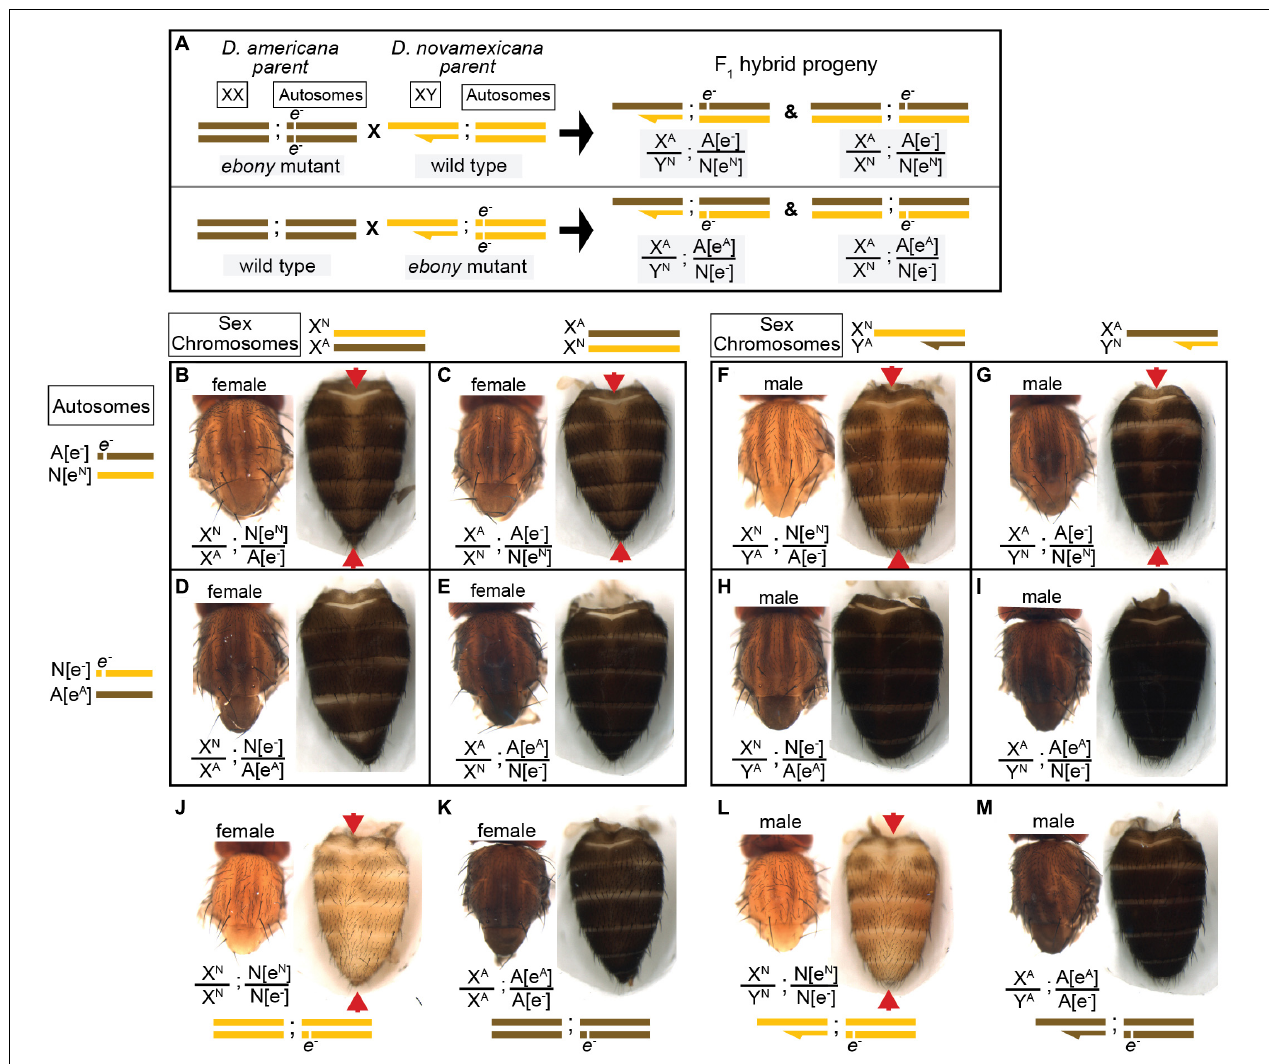
FIGURE 4 | Reciprocal hemizygosity testing shows effects of ebony divergence between D. americana and D. novamexicana on body pigmentation. (A) Schematic shows representative sex chromosomes (XX and XY) and autosomes of the parents and progeny of reciprocal hemizygosity crosses, along with the genotypes of the progeny. Although a single autosome is shown for simplicity, these species have five autosomes. Superscript “A” and “N”, as well as brown and yellow colored bars, indicate alleles and chromosomes from D. americana and D. novamexicana , respectively; e - indicates an ebony null allele. Although the schematic illustrates the crosses only with D. americana as the female parent, the same crosses were performed with sexes of the parental species reversed. (B–I) Dorsal thorax and abdomen phenotypes are shown for female (B–E) and male (F–I) progeny of reciprocal hemizygosity crosses. Genotypes of autosomal and sex chromosomes are shown to the left and above panels (B–I) , respectively, using the same schematic notation as in panel (A) . Individuals in panels (B,C,F,G) carry a wild-type copy of D. novamexicana ebony allele, whereas individuals in panels (D,E,H,I) carry a wild-type copy of the D. americana ebony . (J–M) Dorsal thorax and abdomen phenotypes are shown for female (J,K) and male (L,M) flies heterozygous for the ebony null allele in D. novamexicana (J,L) and D. americana (K,L) for comparison to flies shown in panels ( B–I) , which also all carry one null and one wild-type ebony allele. Red arrowheads in panels (B,C,F,G,J,L) highlight the reduced dark pigmentation in the abdomen along the dorsal midline relative to lateral